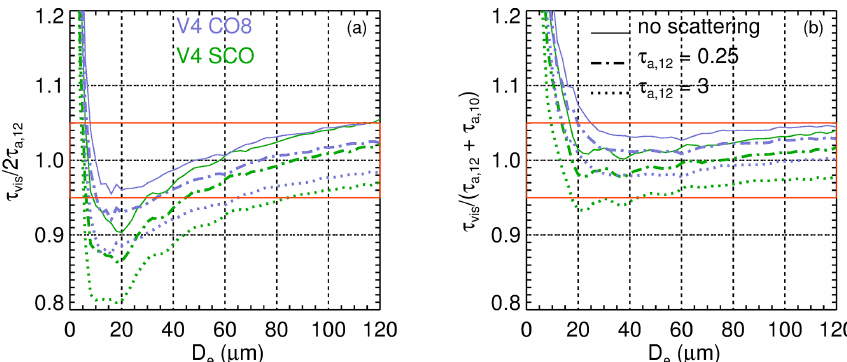
Figure 13. Comparison of (a) τ vis / 2 τ a , 12 and (b) τ vis /(τ a , 12 + τ a , 10 ) vs. D e for the V4 CO8 (purple) and SCO (green) ice models. Simulations with no scattering (solid line) and with scattering using τ a , 12 = 0 . 25 (dashed–dotted lines) and τ a , 12 = 3 (dotted lines). The red rectangle identifies the domain within ± 5% limits.